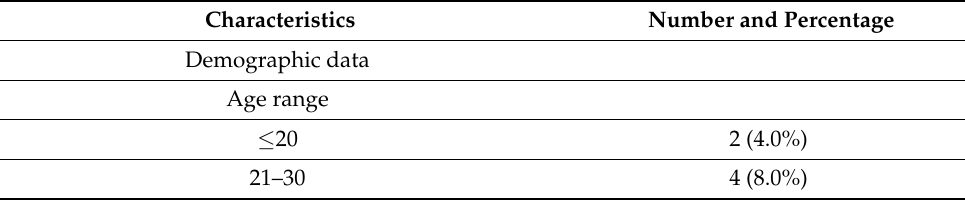
Table 1. Demographic and clinical characteristics of participants in